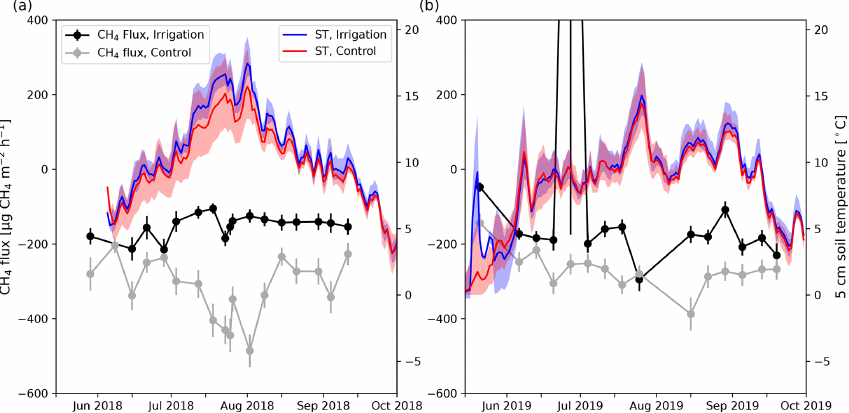
Figure 5. Daily mean CH 4 flux measured at the irrigated (black) and control (gray) plots in 2018 (a) and 2019 (b) . The error bars show the standard error of the mean. Blue (irrigated) and red (control) lines represent daily mean 5cm soil temperature (ST) and shading shows the minimum and maximum daily values measured by different sensors (irrigation: n = 7; control: n =